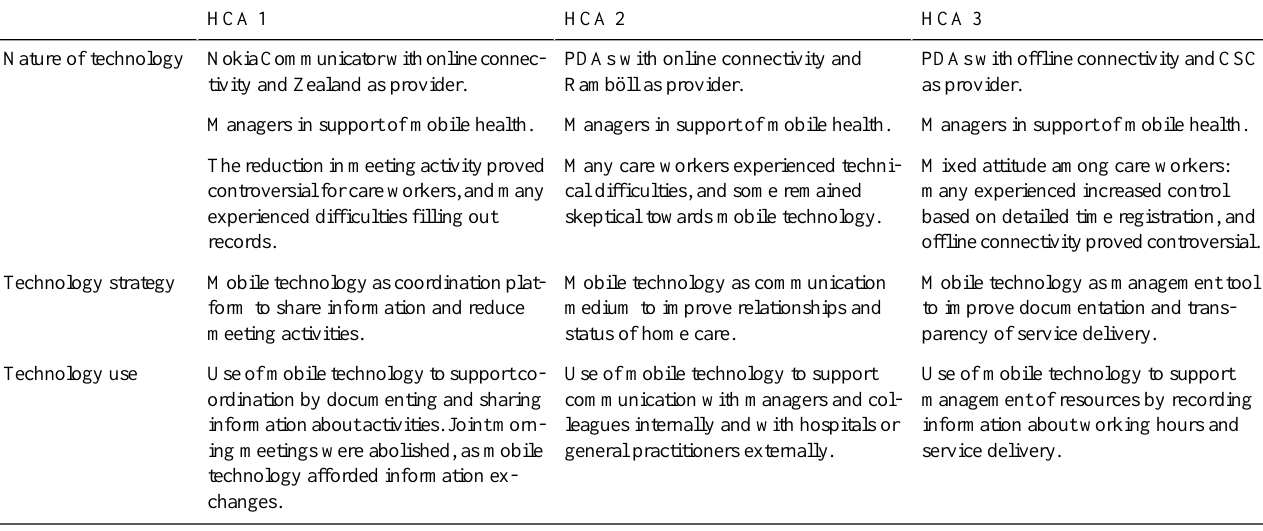
Table 3. Interpretive flexibility in mobile health across three